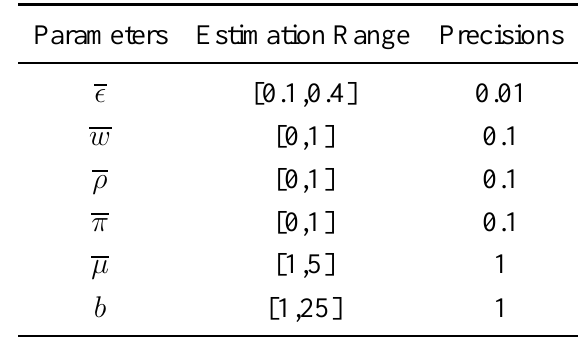
Table 1. Parameter estimation